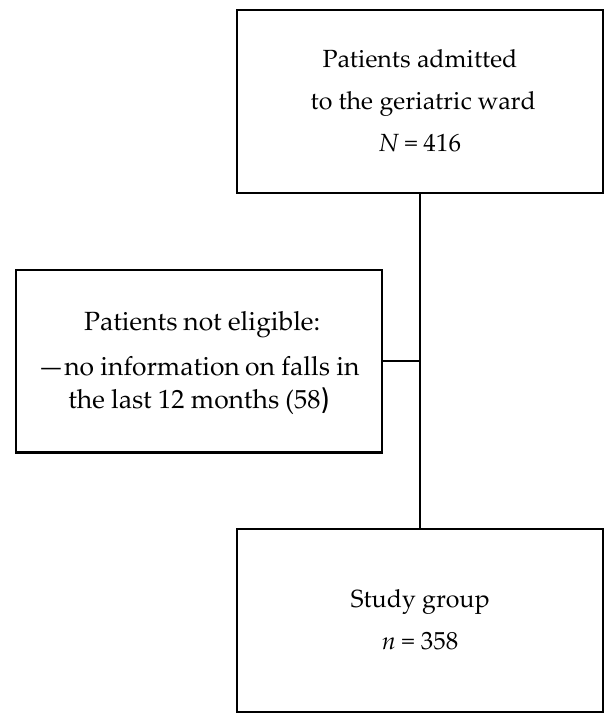
Figure 1. Flow chart of patient enrollment.